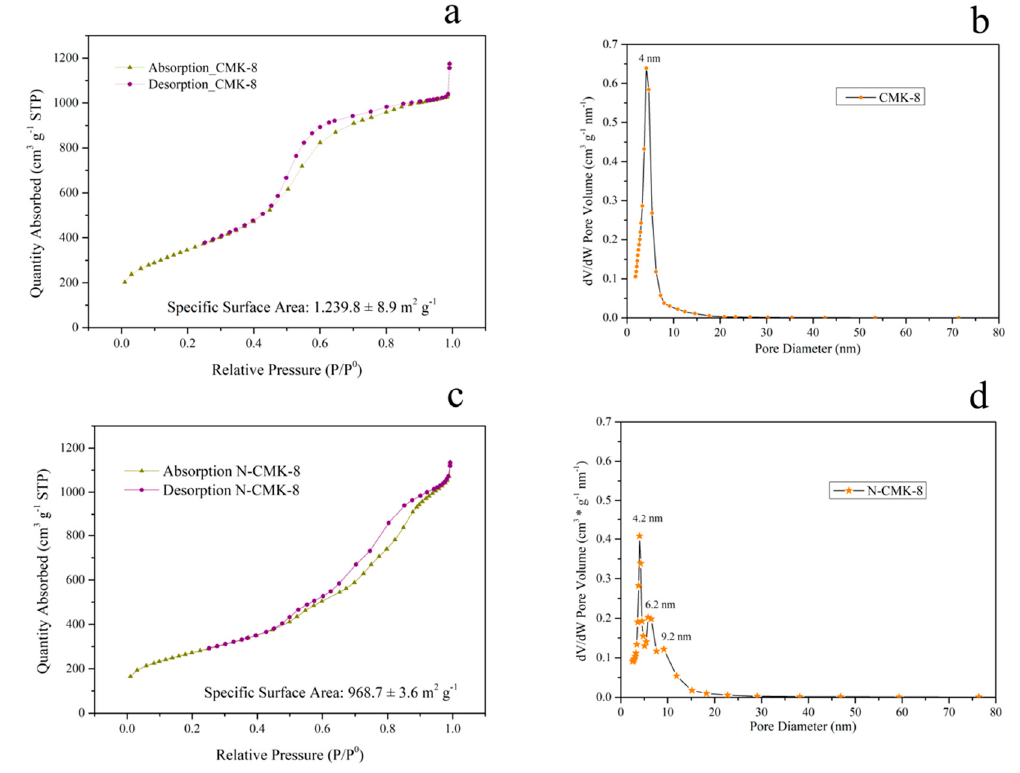
Figure 1. Barret–Joyner–Halenda (BJH) sorption isotherms (with P 0 = vapor pressure of the adsorbate) and pore size distributions of CMK-8 and N-CMK-8. ( a ) Absorption and Desorption Curves of CMK-8, ( b ) Pore size distribution of CMK-8. The distribution peak is centered at 4 nm, ( c ) Absorption and Desorption Curves of CMK-8, ( d ) Pore size distribution of N-CMK-8. The distribution peaks are centered at 4.2, 6.2 and 9.2 nm.